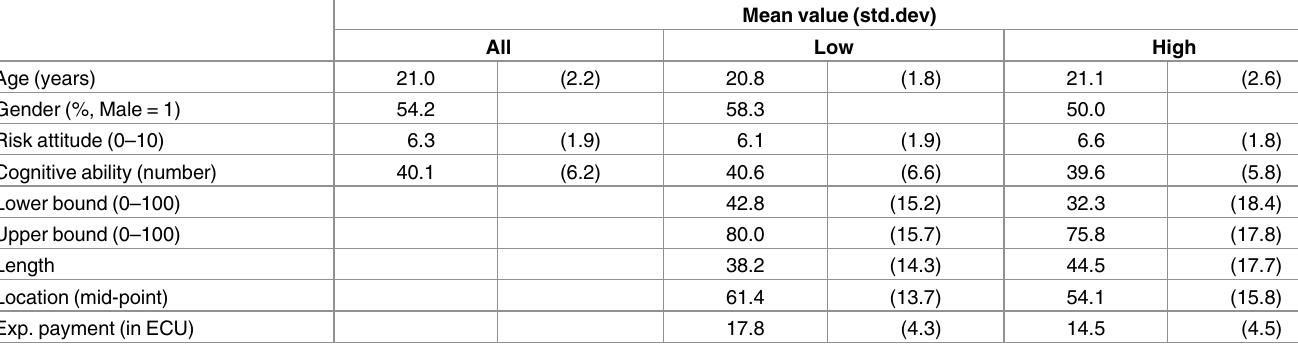
Table 1. Summarystatistics of the participants in the